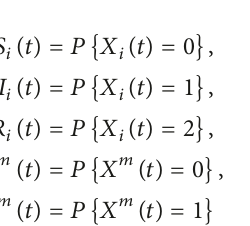
Figure 1: The schematic diagram of node-based SIRS network model with media. (a) The SIRS network part and (b) the media part.